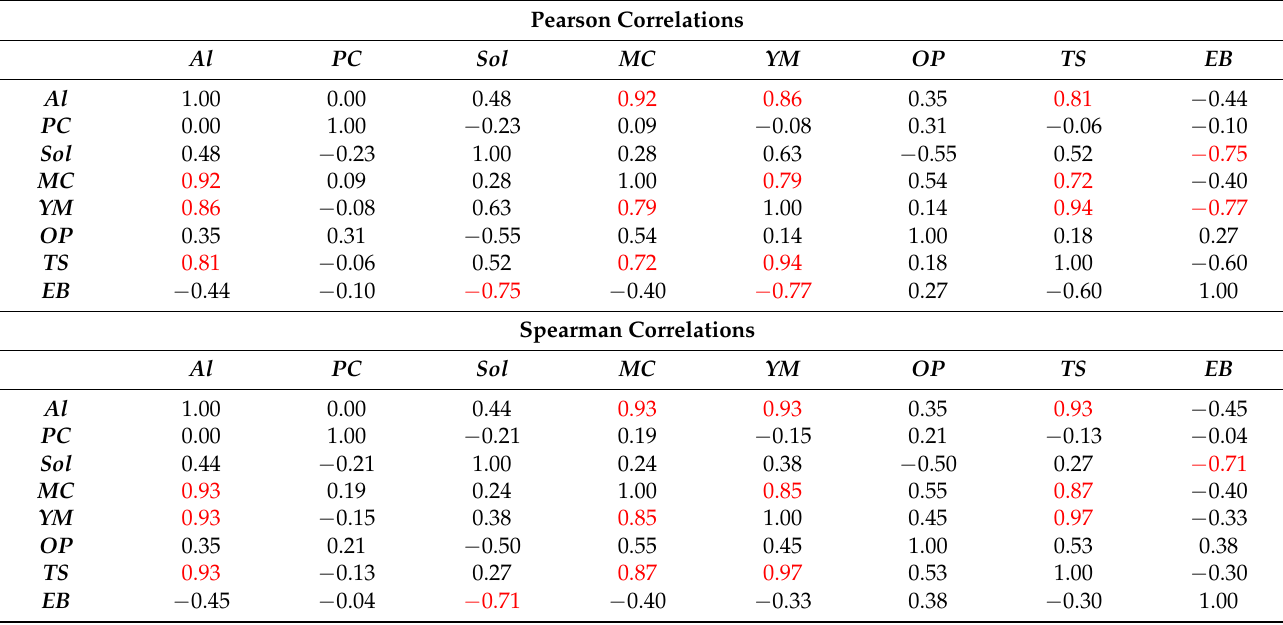
Table 6. Pearson’s and Spearman’s correlation matrices. Pearson